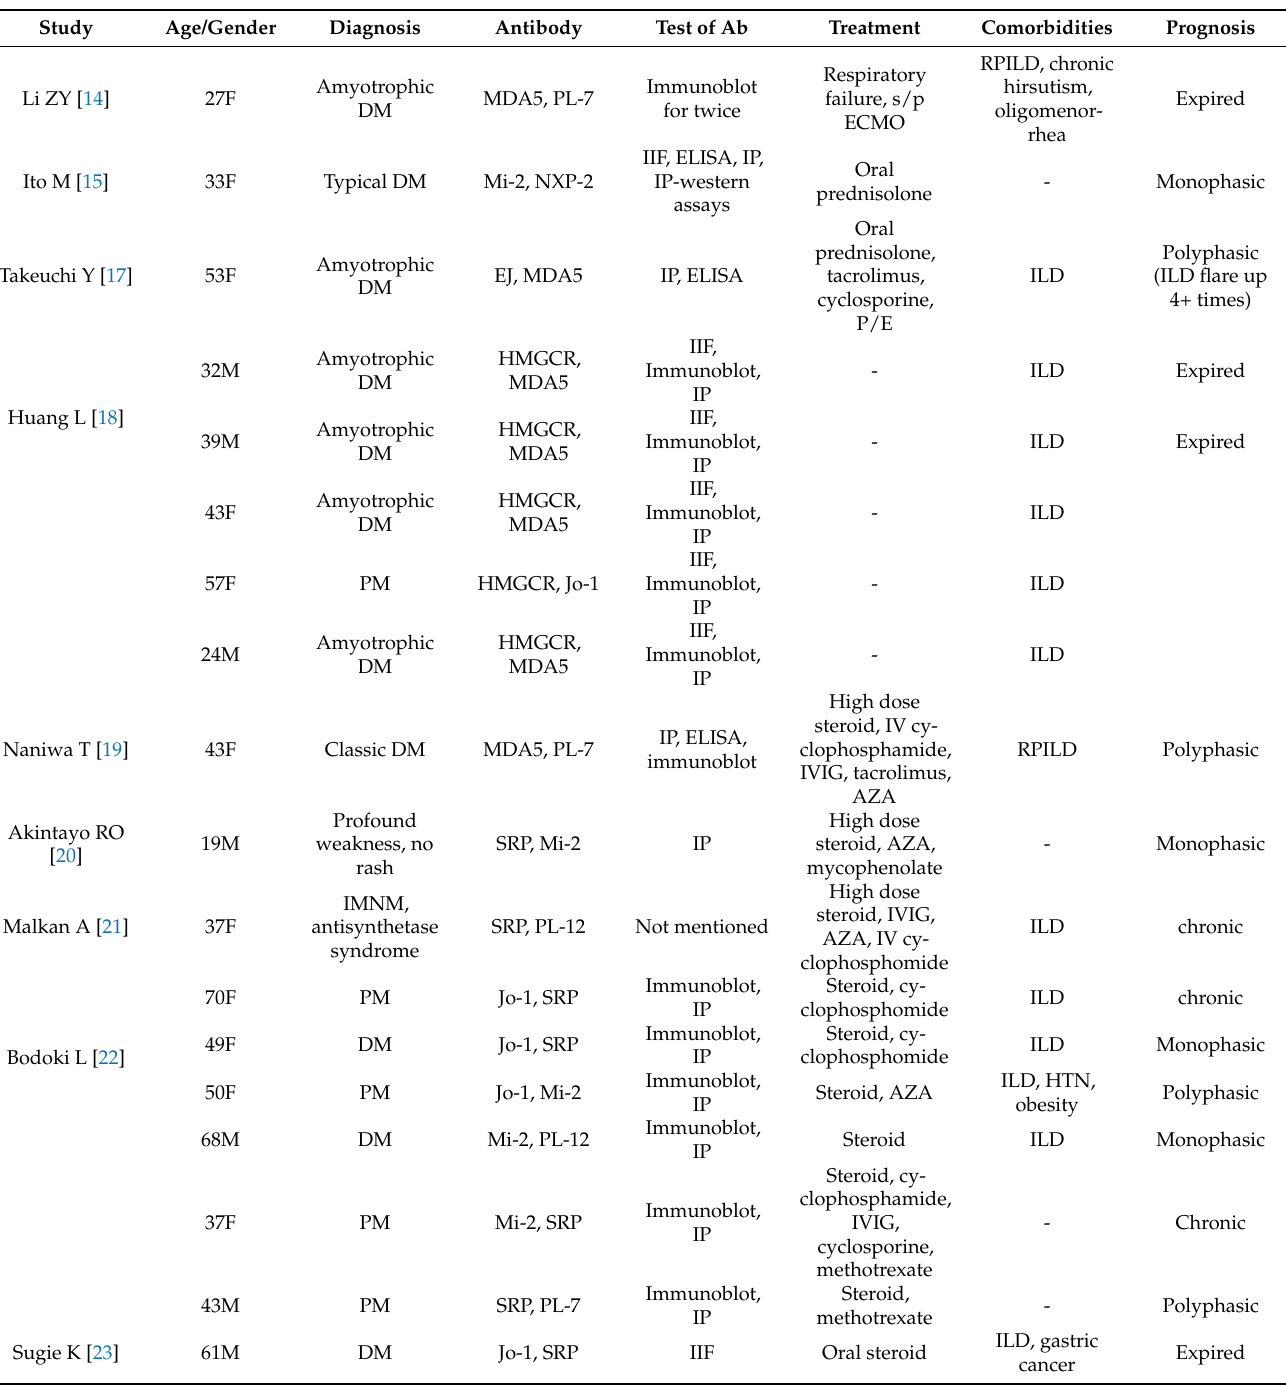
Table 4. Literature